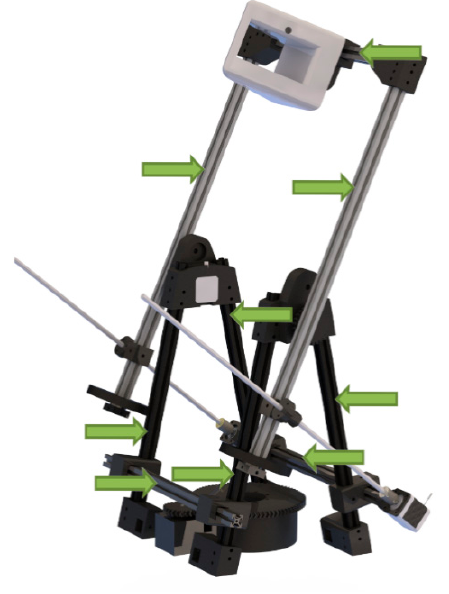
Figure 3. Structural elements. (Source: self-made).